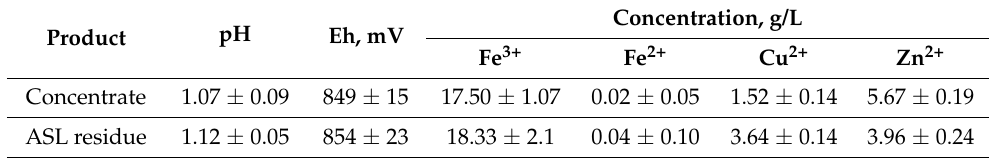
Table 3. Parameters of the liquid phase of the pulp during continuous bioleaching (average